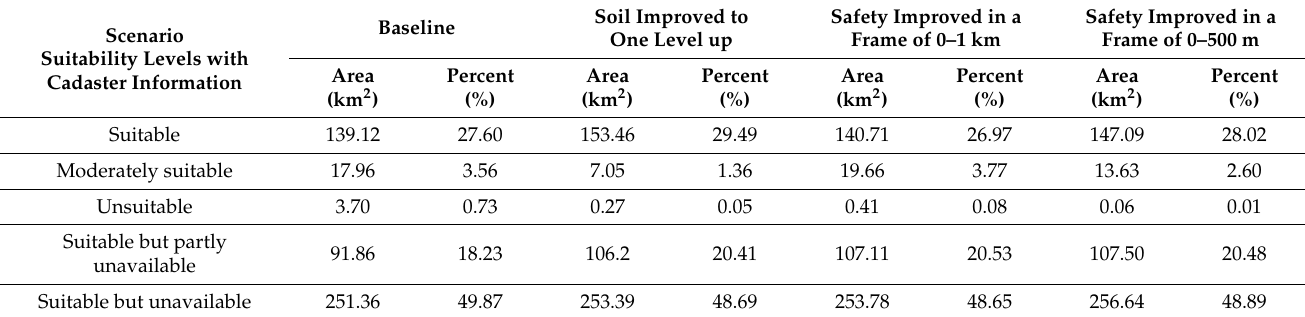
Table 8. Urban agriculture suitability combined with cadaster